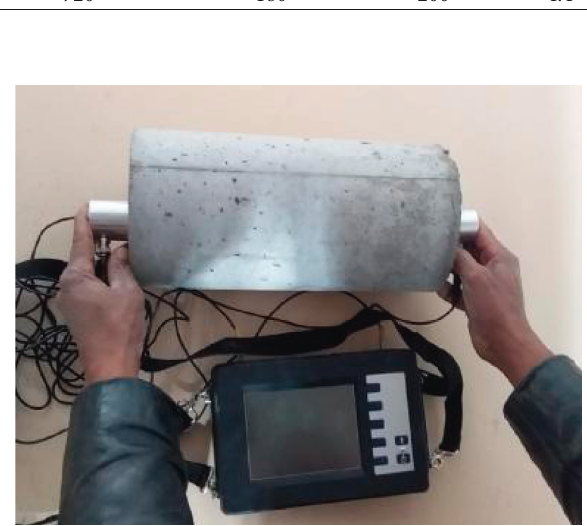
Figure 4: Ultrasonic pulse velocity test method.